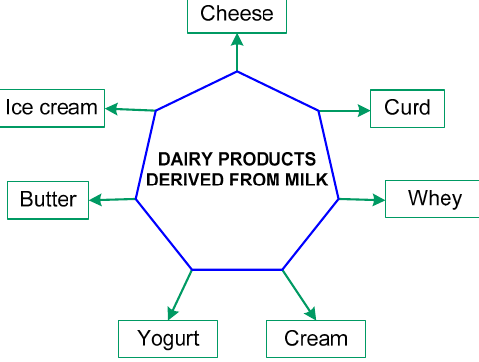
Figure 13. Dairy products derived from milk.